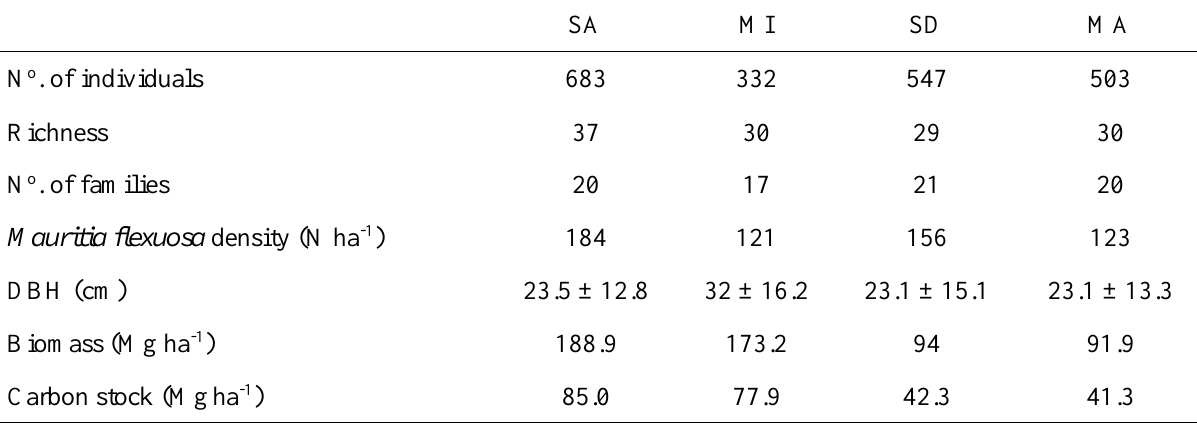
Mires and Peat , Volume 29 (2023), Article 12, 19 pp., http://www.mires-and-peat.net/, ISSN 1819-754X International Mire Conservation Group and International Peatland Society, DOI: 10.19189/MaP.2021.OMB.StA.2300